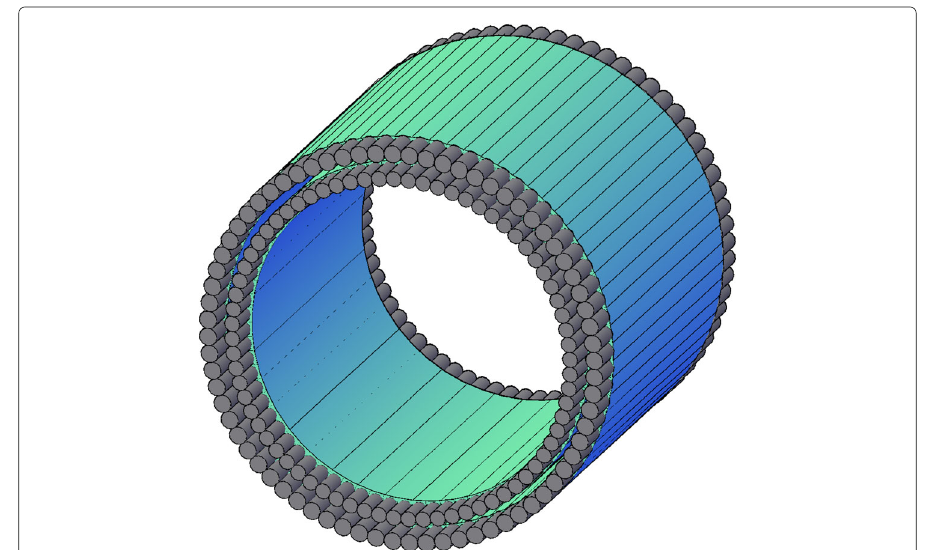
Fig. 14 The axial arrangement allows for concentric layers of scintillation material